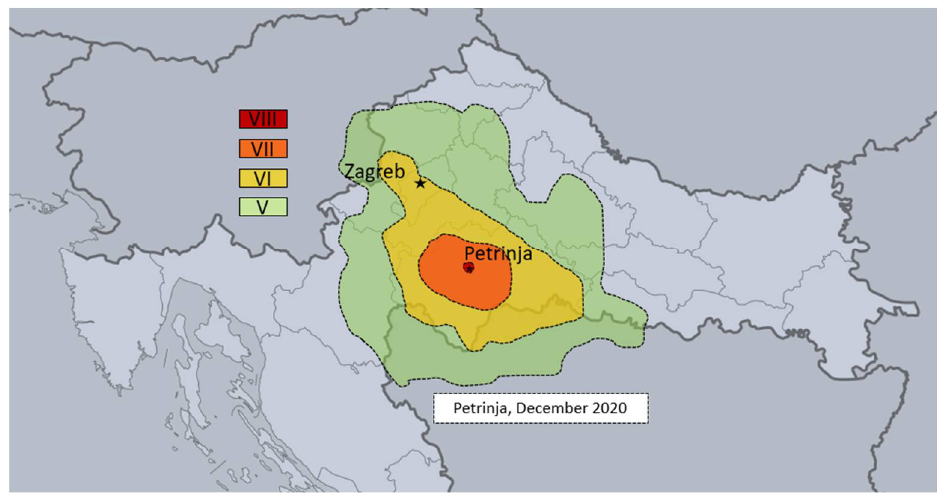
Figure 1. Petrinja earthquake intensity map according to EMS-98.